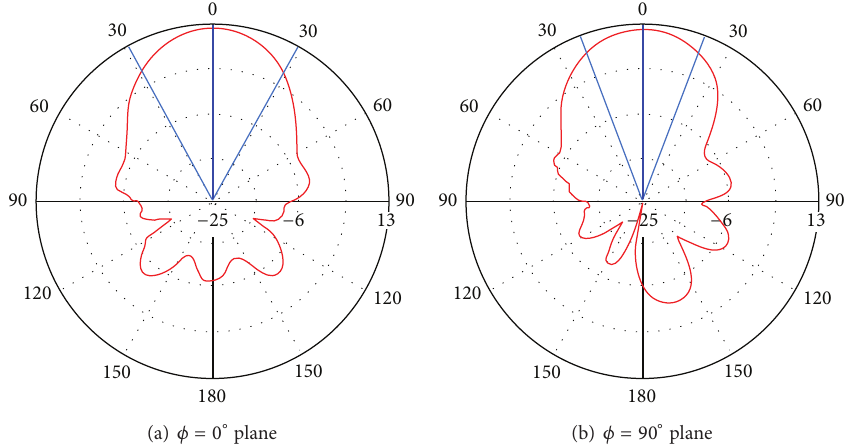
Figure 18: Gain patterns of the proposed curved-cut antenna with the optimized reflector position and shape, computed using CST.